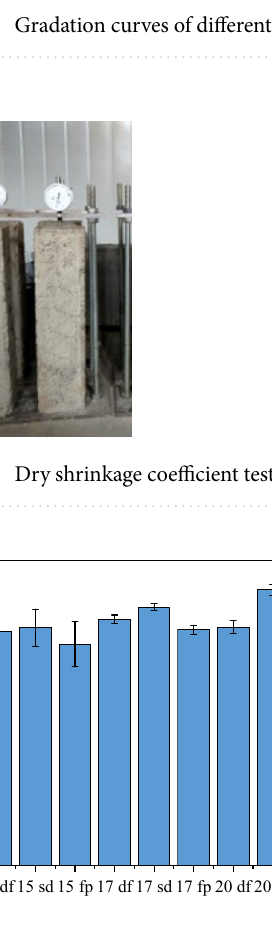
Figure 6. Dry shrinkage coefficients of lime and fly ash-stabilized